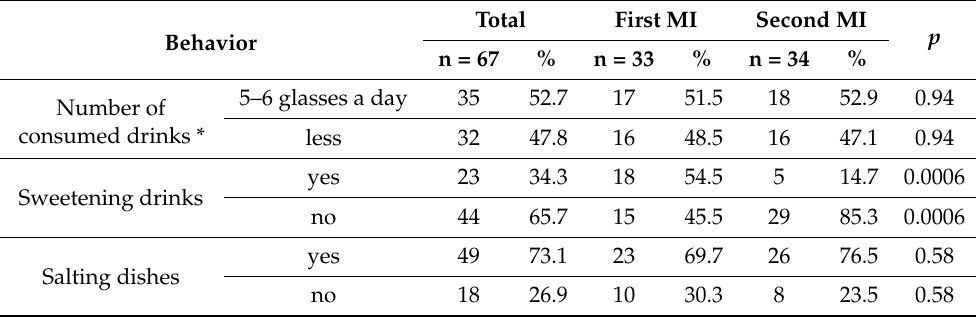
Table 7. Selected dietary behaviors in the study group in total and by MI history (n = 67). * except